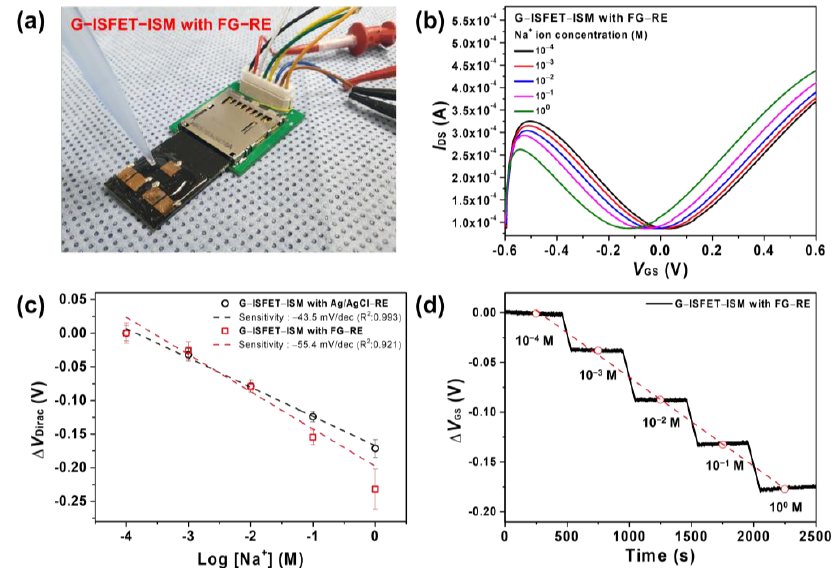
Figure 4. ( a ) Experimental setup using G–ISFET–ISM with FG–RE; ( b ) I DS – V GS of G–ISFET–ISM with FG–RE depending on Na + ion concentration; ( c ) the sensitivity of G–ISFET–ISM